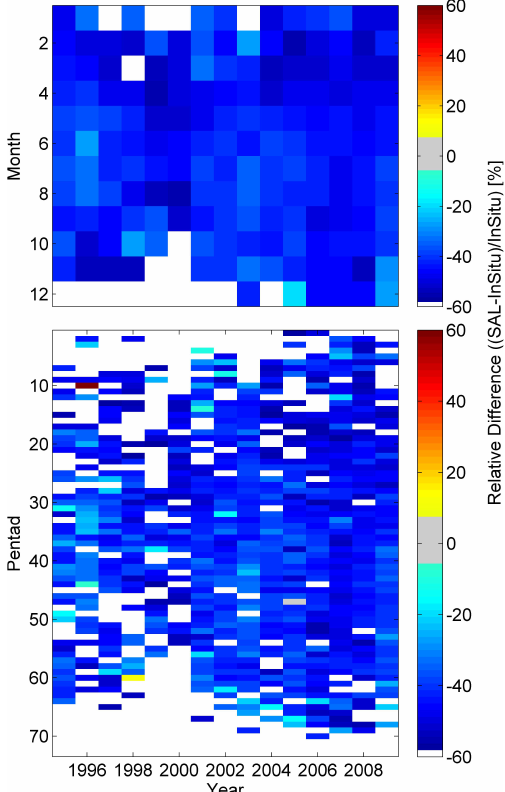
Fig. 4. Same as Fig. 3, but at Payerne between